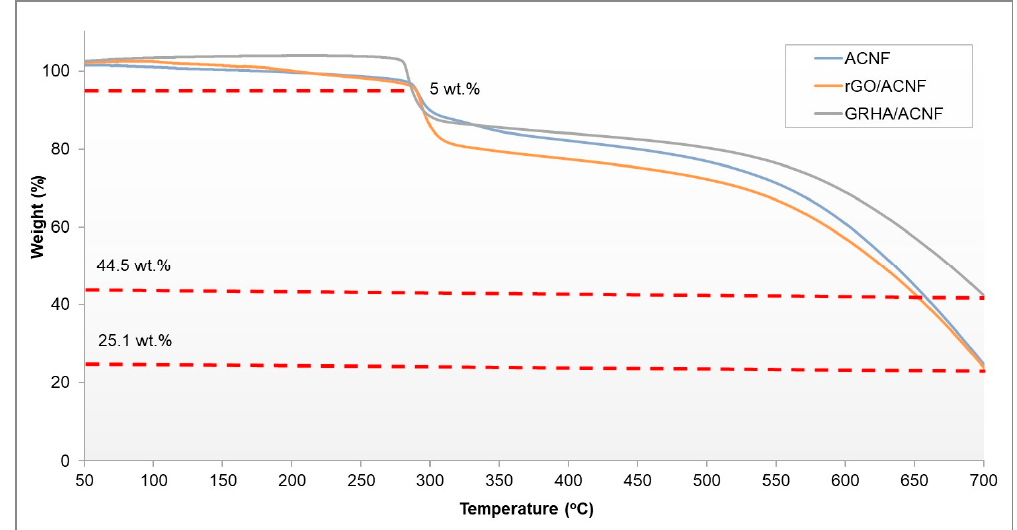
Figure 1. TGA thermogram of the samples. ACNF: activated carbon nanofibers, rGO: ACNF: activated carbon nanofibers, GRHA: graphene-derived rice husk ashes.